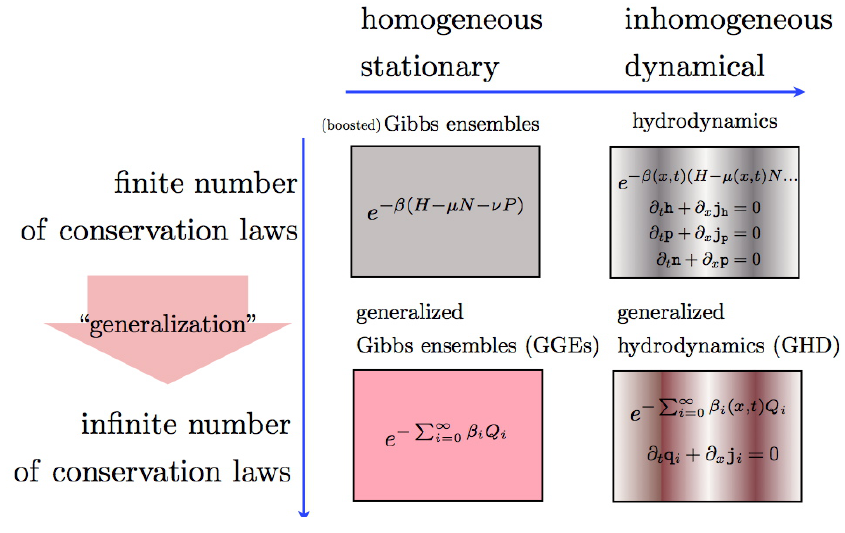
Figure 12: Where GHD